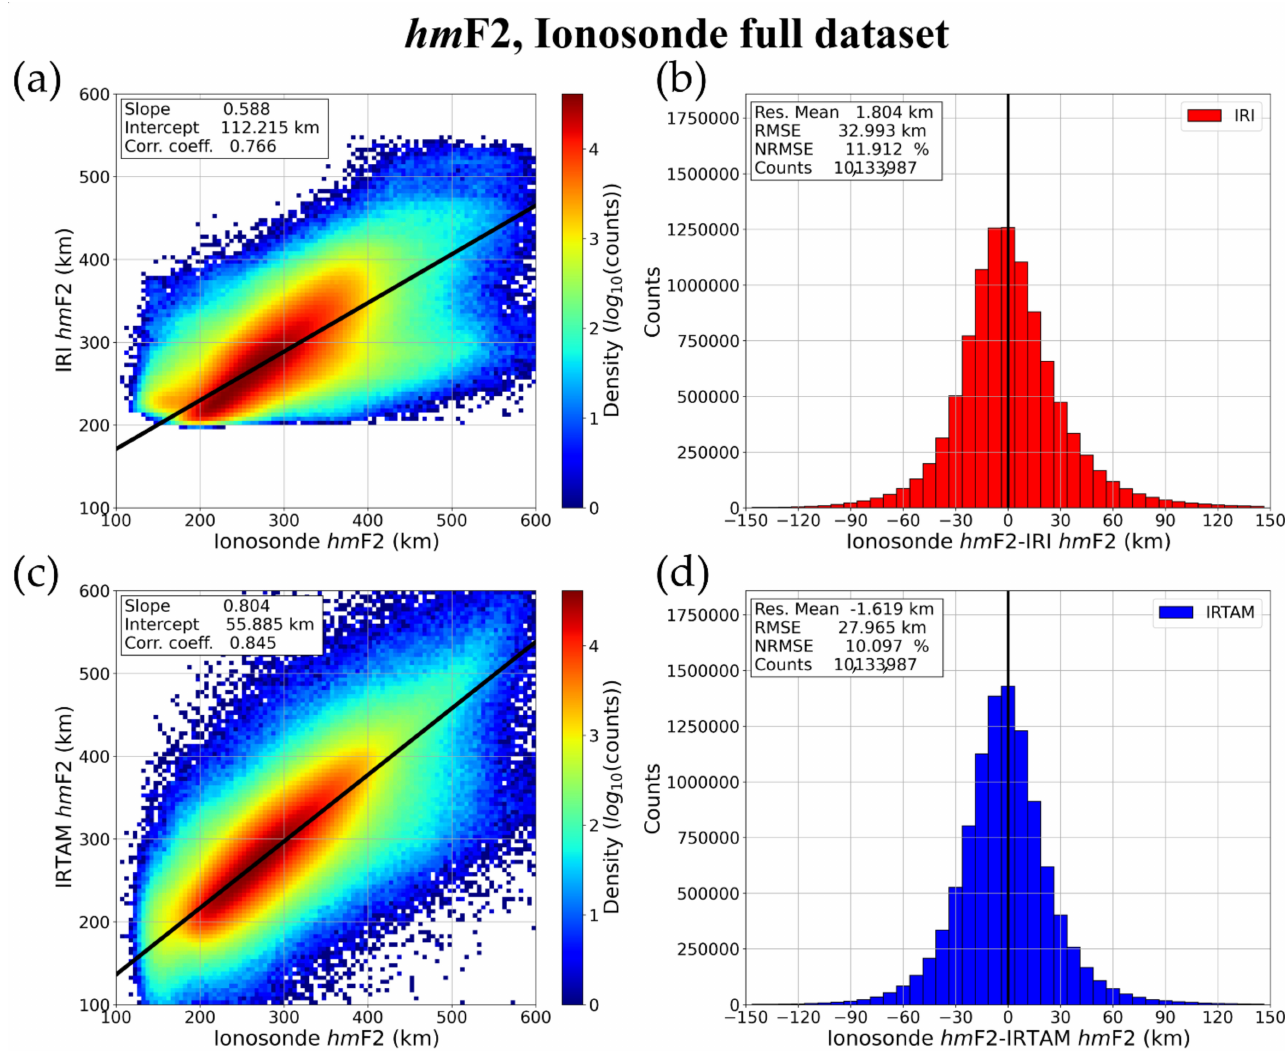
Figure 24. Density plots between measured ( x -axis) and modeled ( y -axis) hm F2 values, for ( a ) IRI and ( c ) IRTAM. Measured values are those from the entire ionosonde dataset. The black solid lines represent the best linear fit. Corresponding slope and intercept values, along with the correlation coefficient, are reported in the upper left box of each plot. Statistical distributions of the resultant residuals for ( b ) IRI and ( d ) IRTAM. Corresponding Res. Mean , RMSE , and NRMSE values, along with the total number of counts on which the statistics is based, are reported in the upper left box of each